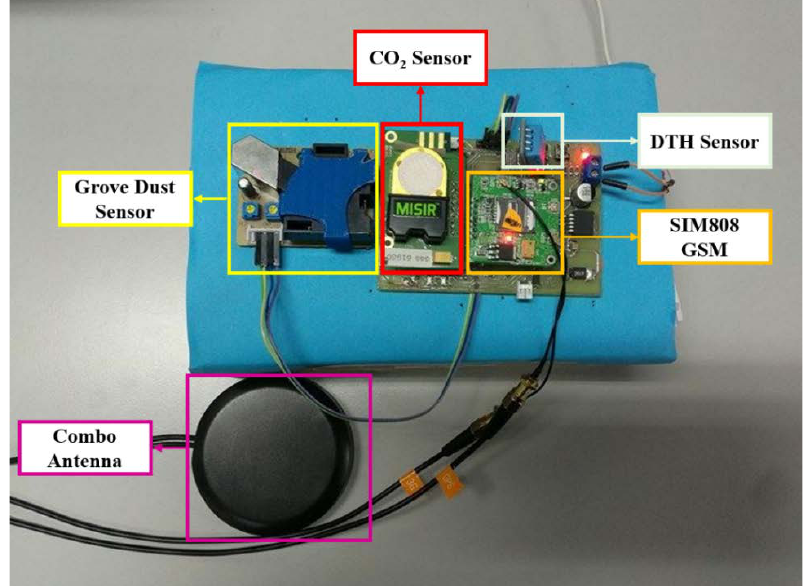
Figure 3. Development of Sensors in the Device Node.